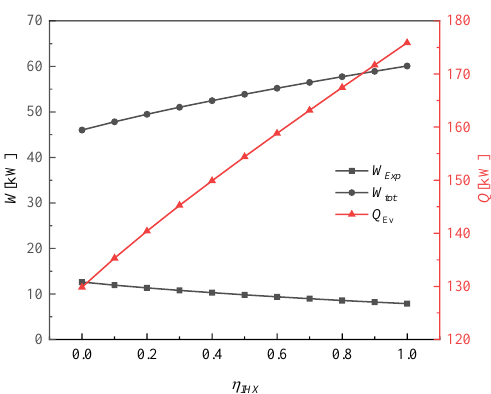
Figure 7. Effect of η IHX on system power consumption and cooling capacity.